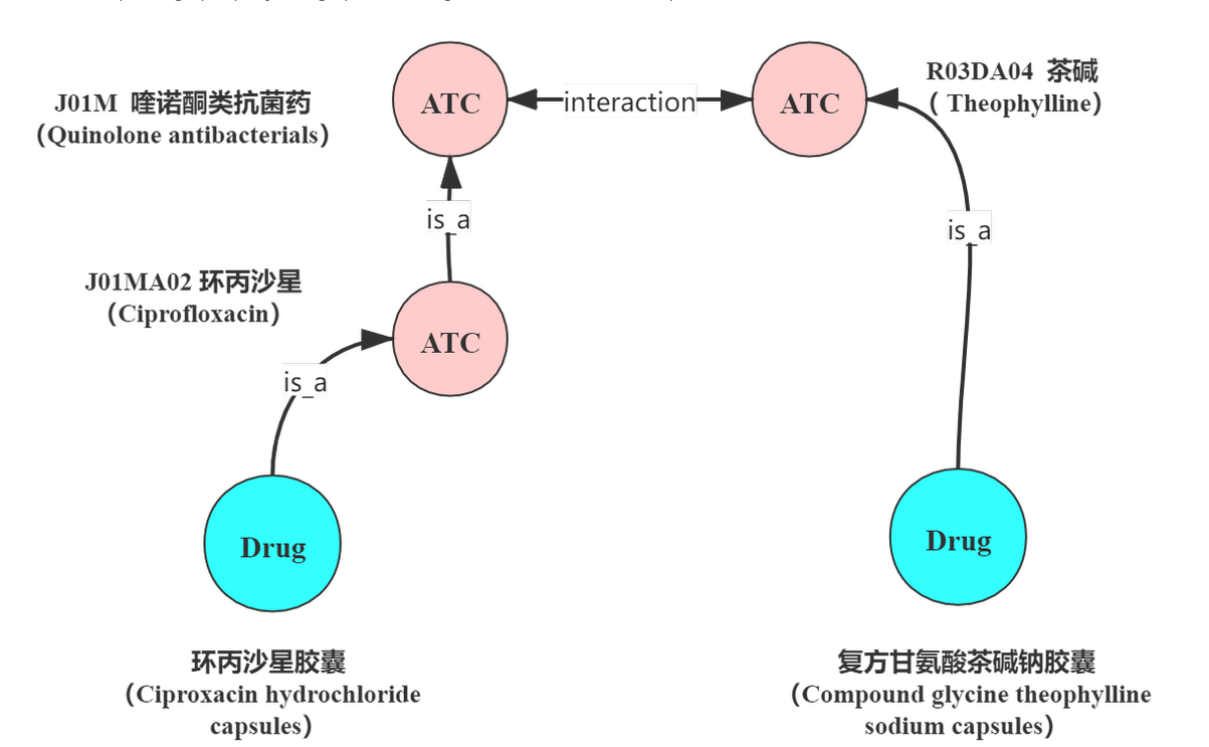
Graph reasoning rule (Cypher-like syntax)Suspicious scenarios